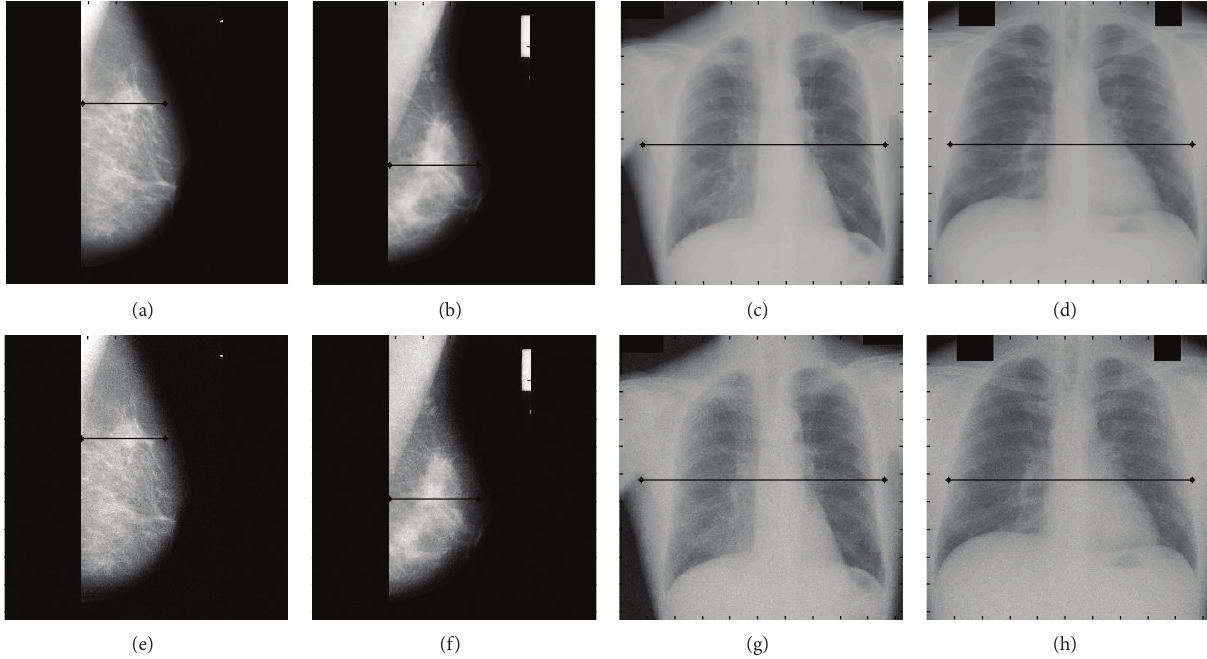
Figure 2: Examples of images used for this study. Images shown in the upper row are original images: (a) and (b) are two mammograms and (c) and (d) are two chest radiographs. The corresponding images are in the lower row with external added noise.